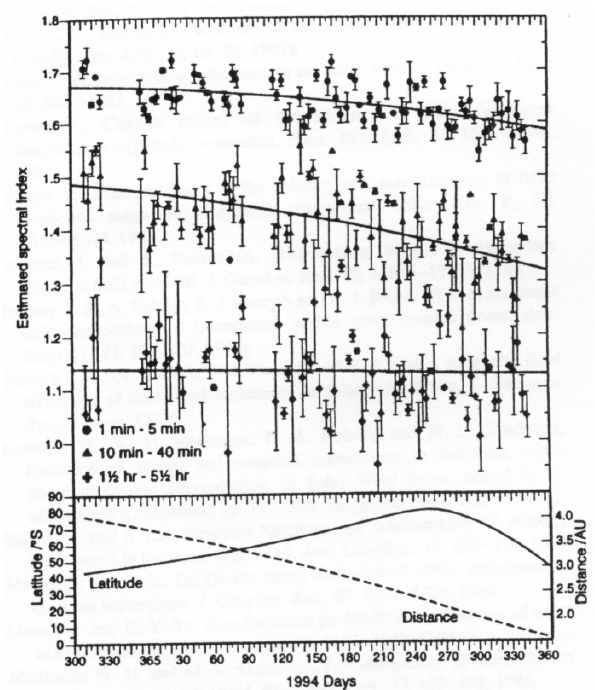
Figure 54: Spectral indexes of magnetic fluctuations within three different time scale intervals as indicated in the plot. The bottom panel shows heliographic latitude and heliocentric distance of Ulysses. Image reproduced by permission from Horbury et al. (1995c), copyright by